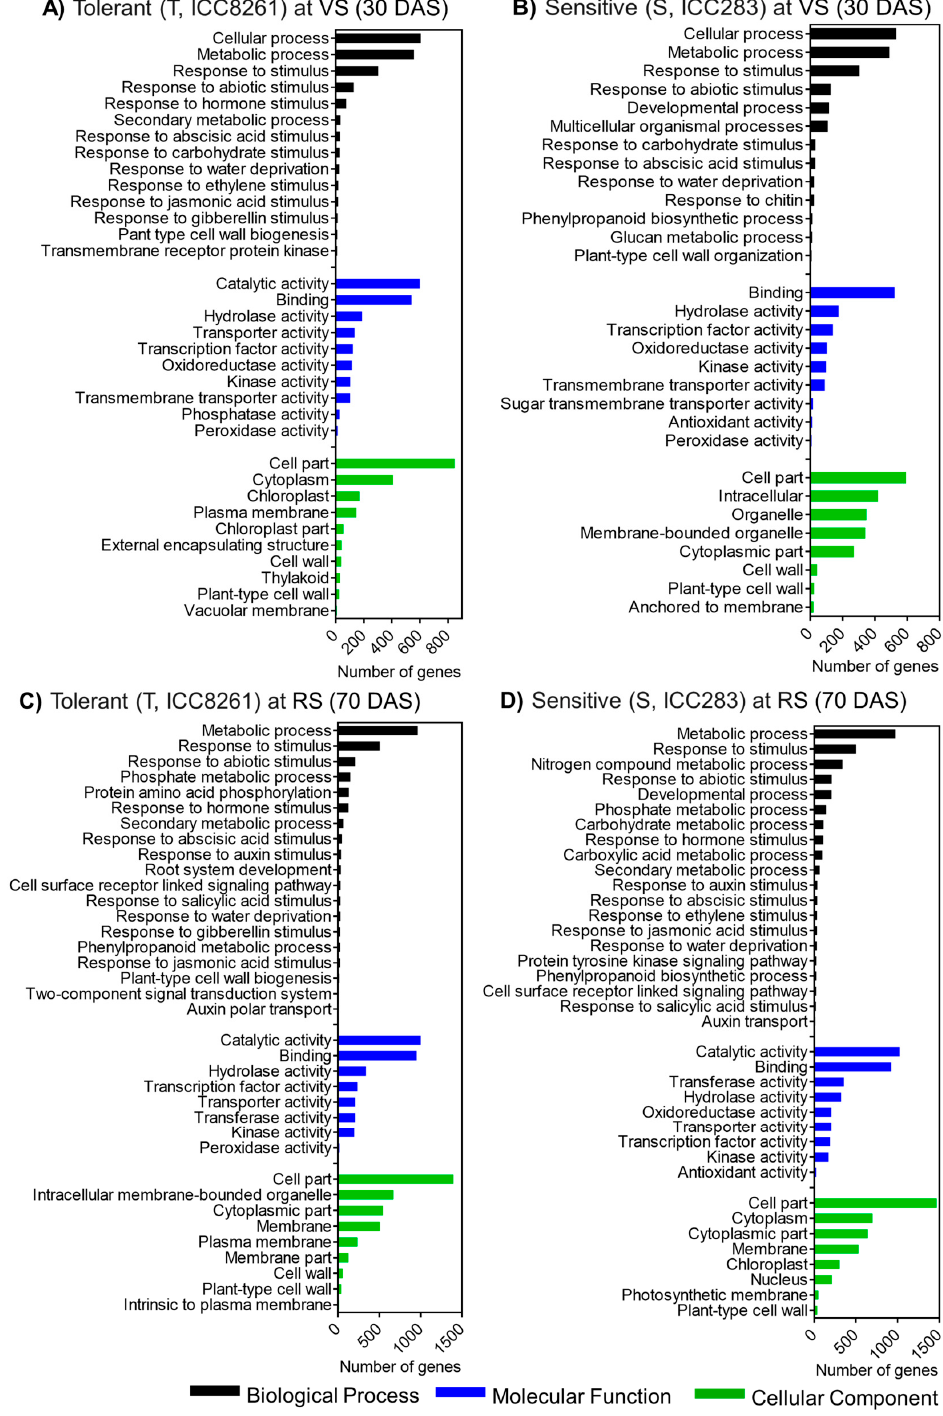
Figure 3. Genotype- and developmental stage-specific enrichment of gene ontology (GO) terms in ( A ) tolerant (T, ICC8261) genotype at vegetative stage (VS) ( B ) sensitive (S, ICC283) genotype at vegetative stage (VS) ( C ) tolerant (T, ICC8251) genotype at reproductive stage (RS) and ( D ) sensitive (S, ICC283) genotype at reproductive stage (RS).